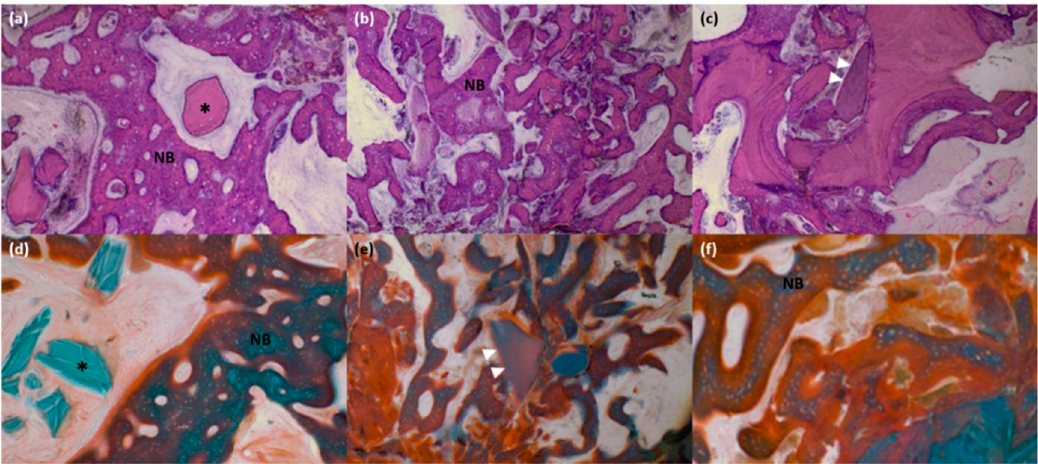
Figure 8. Histomorphometric measurement at 4 months after ridge preservation. Section was stained with Hematoxylin and Eosin (H&E) and Masson’s trichrome with magnification x 100. ( a , d ) Bio-Oss collagen group. ( b , e ) DDM group. ( c , f ) rhBMP-2/DDM group. NB: Newly formed bone, asterisks: residual Bio-Oss particle, arrowheads: residual dentin particle. Table 4. Histomorphometric analysis of 3 different groups at 4 month reentry.